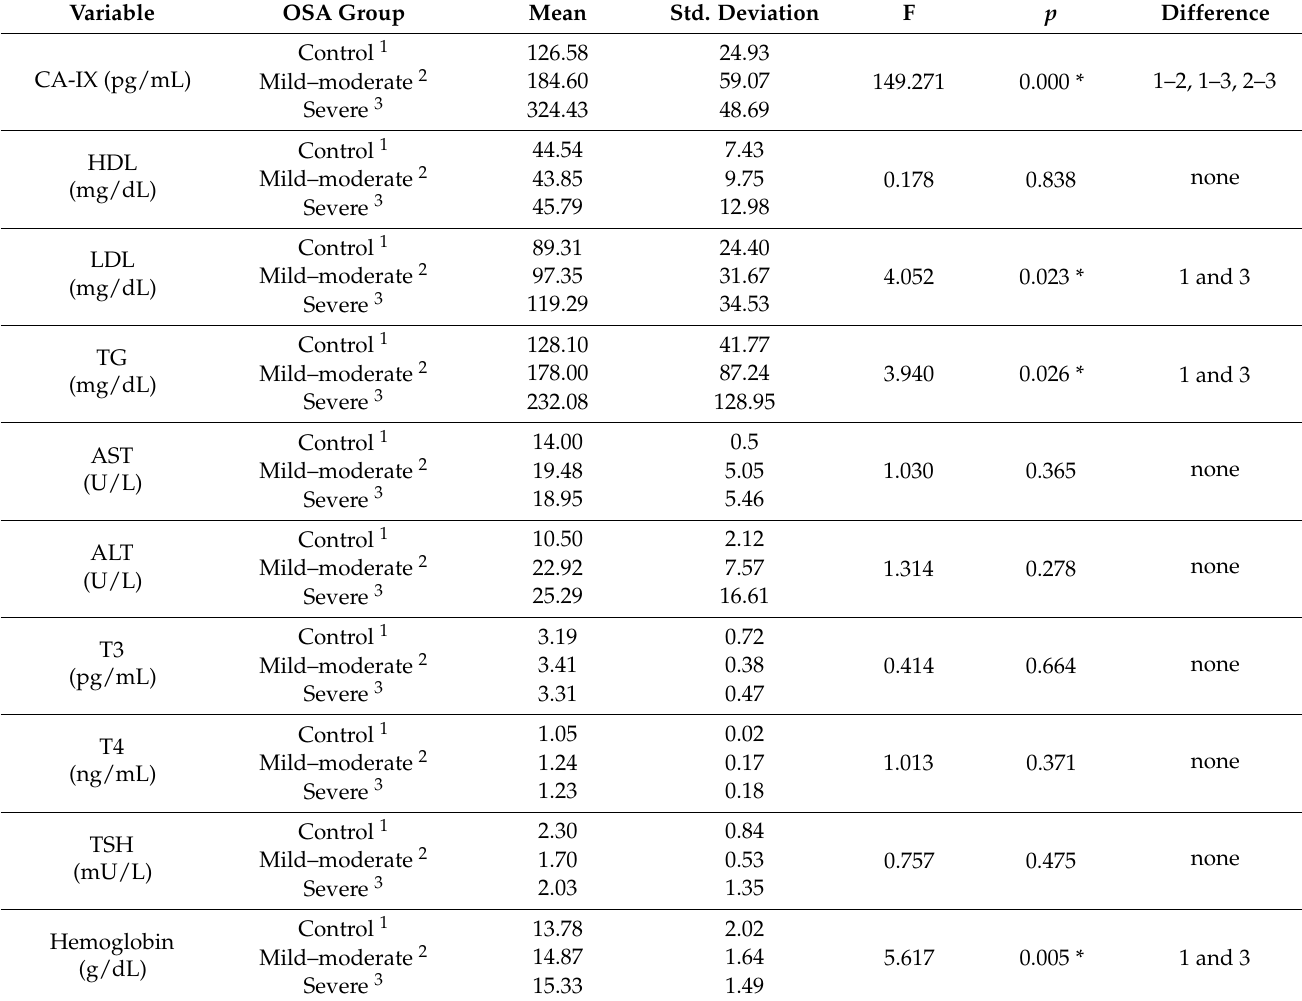
Figure 1. The comparison of serum CA IX levels in OSA groups. Table 2. Evaluation of laboratory levels and CA-IX levels.